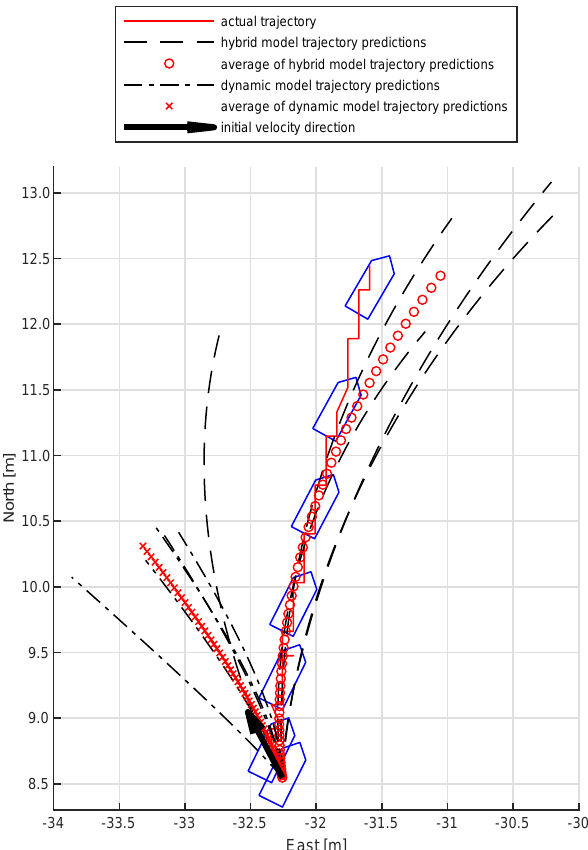
Figure 6: Trajectories of the ship while drifting. The blue ship frames, plotted every 10 seconds, indicate the actual heading angle of the ship.